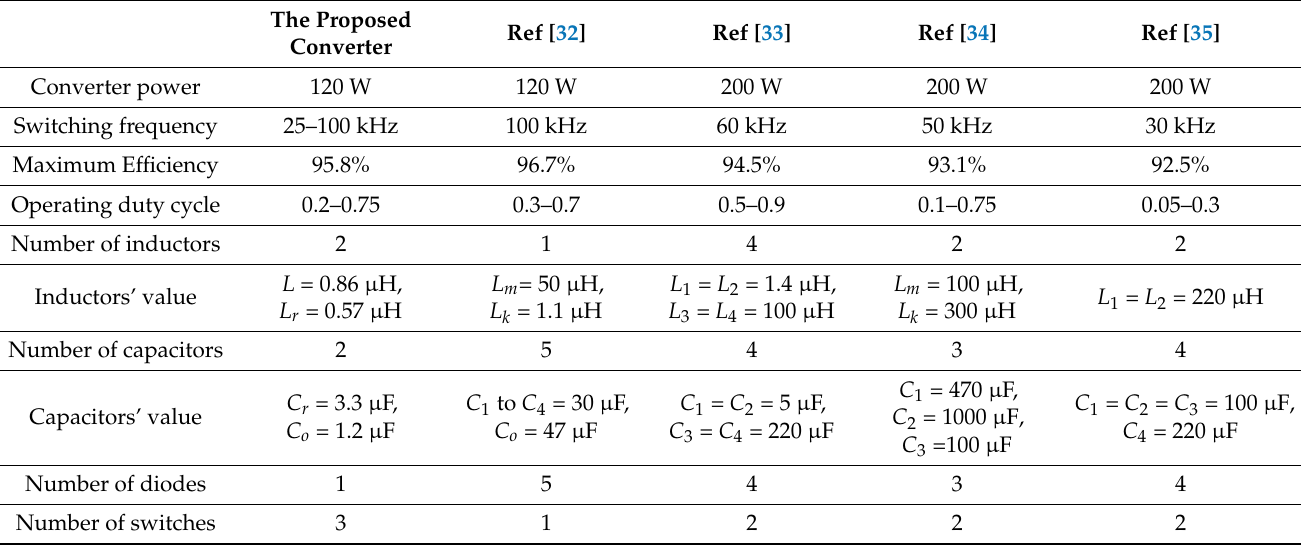
Table 1. Comparison of the proposed DC-DC power converter element size vs. two other high-step- up converters in the